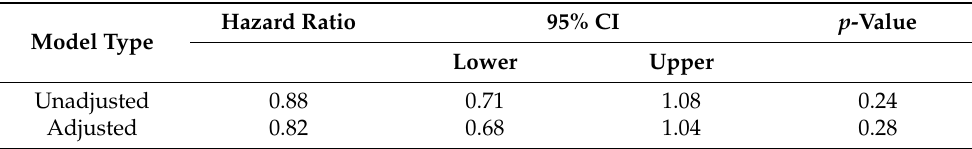
Table 9. Cox regression analysis of patients prescribed statin vs. those not prescribed statin; outcome—ASCVD event.